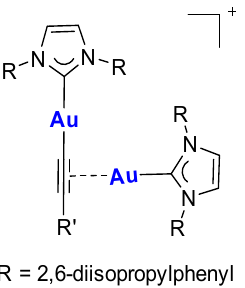
Figure 4. Structure of [IPr 2 Au 2 (C ≡ CR’)] + type complexes reported in [22,23].